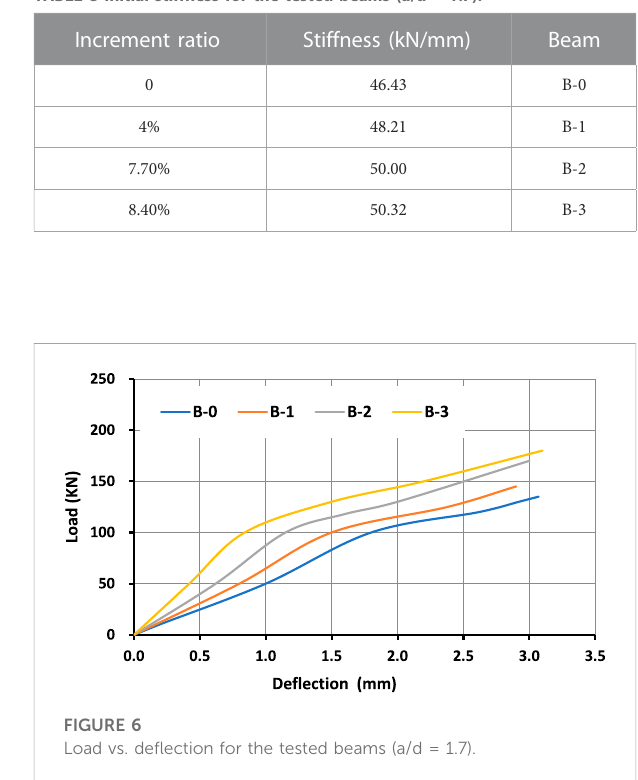
TABLE 8 Initial stiffness for the tested beams (a/d = 1.7).